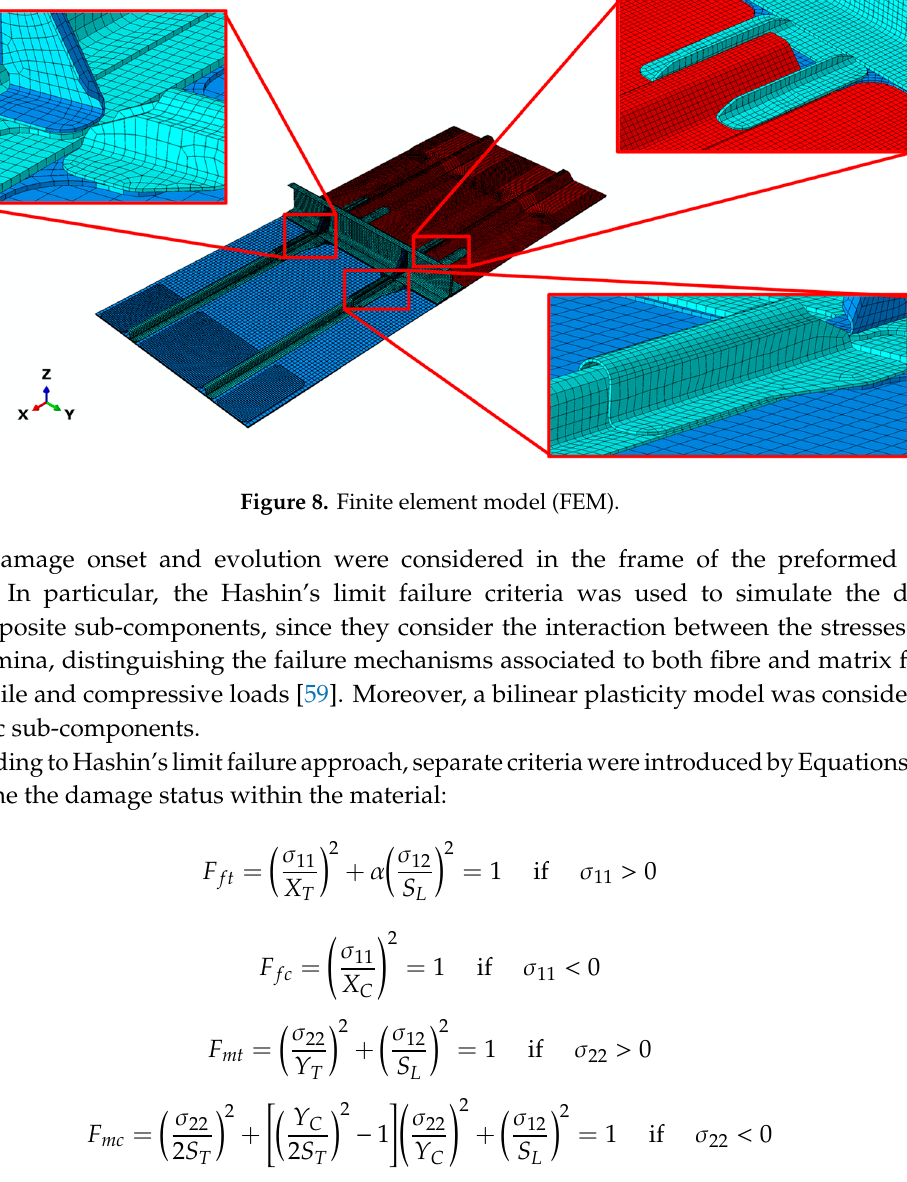
Figure 7. Test rig.